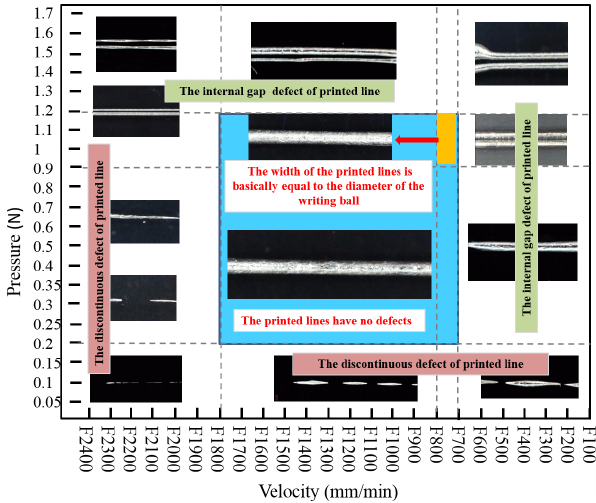
Figure 9. The process windows for effectively obtaining the opti- mized